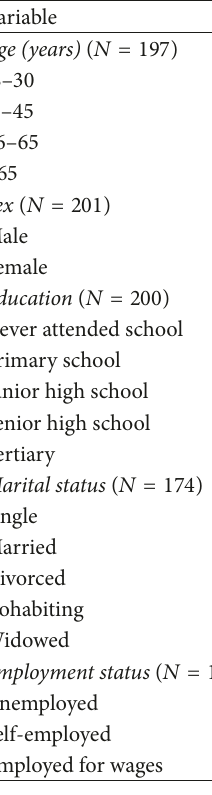
Table 2: Sociodemographic characteristics of